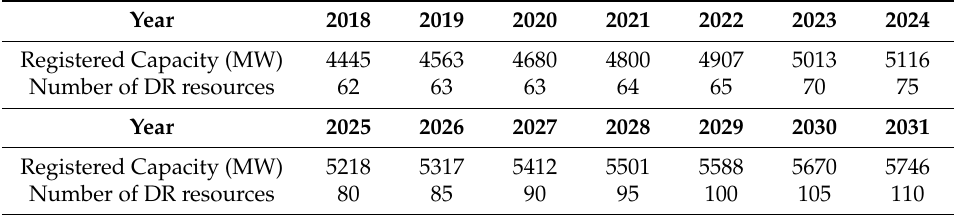
Table 2. DR resource registration capacity per year